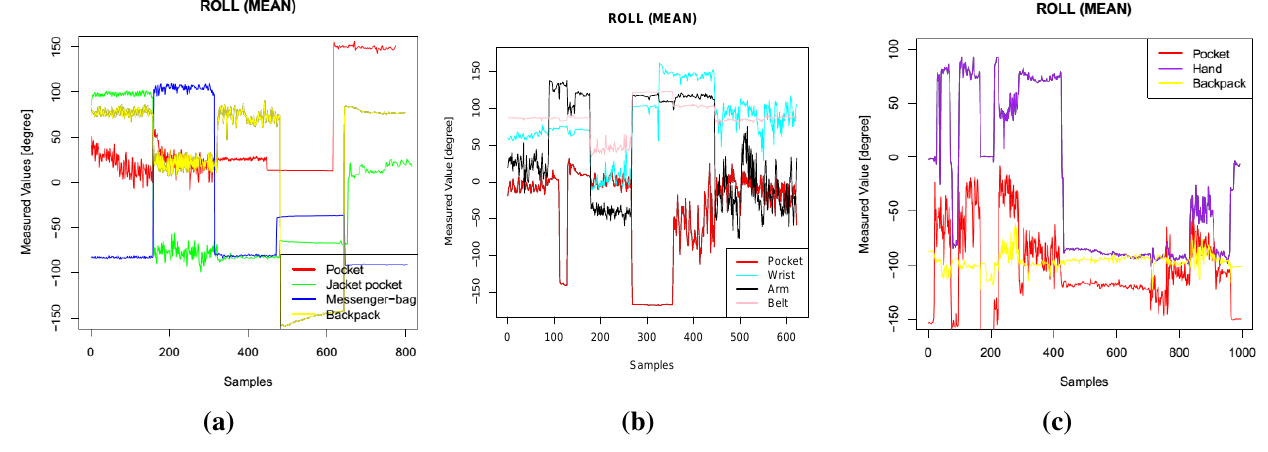
Figure 2. Roll features. ( a ) Dataset 1; ( b ) Dataset 2; ( c ) Dataset